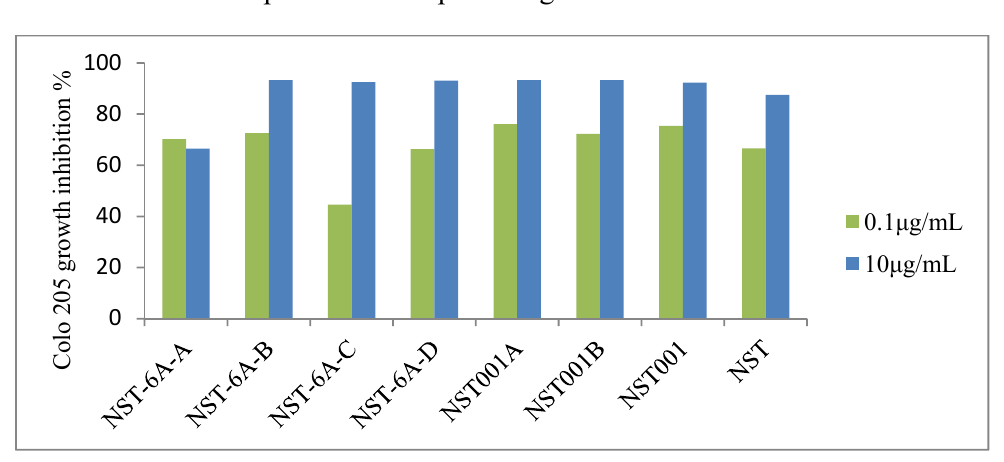
Figure 2. The inhibitory rate (at concentrations of 0.1, 10 μ g/mL for 72 h) on Colo 205 growth. The results are expressed as the percentage of that of the treat